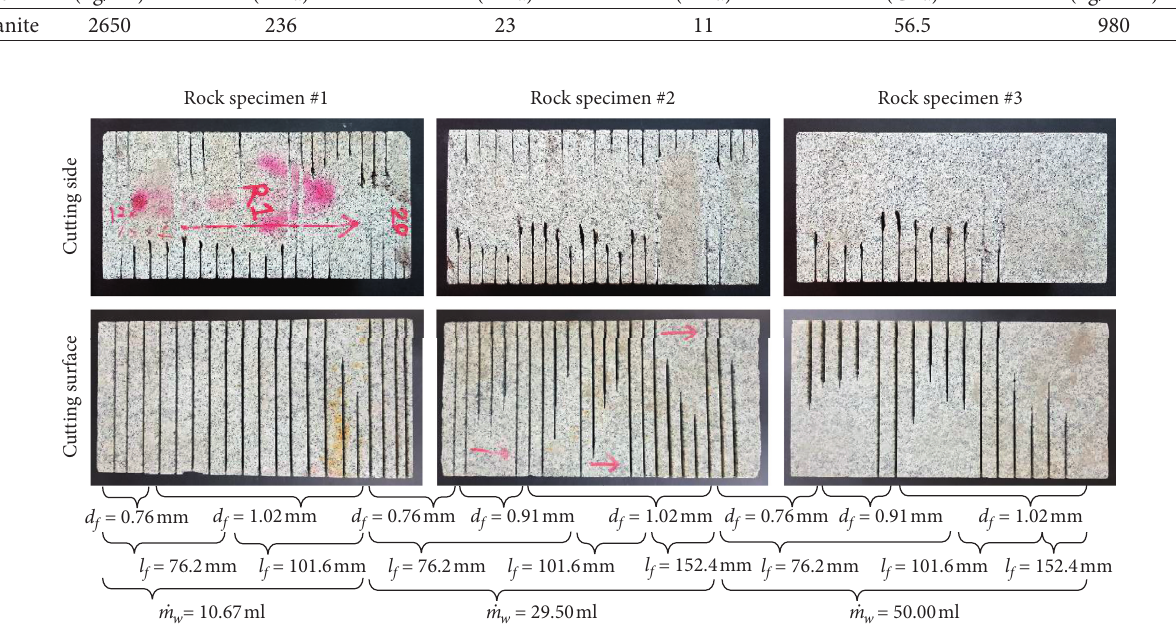
Figure 6: Cutting results of an abrasive waterjet with different focus geometry and water flow rates.